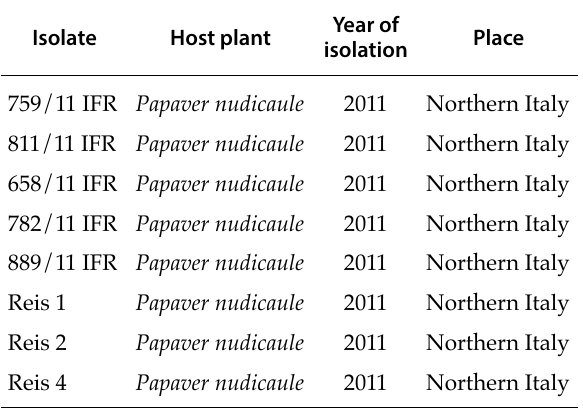
Table 1. Fusarium oxysporum isolates from Papaver nudicaule used in this